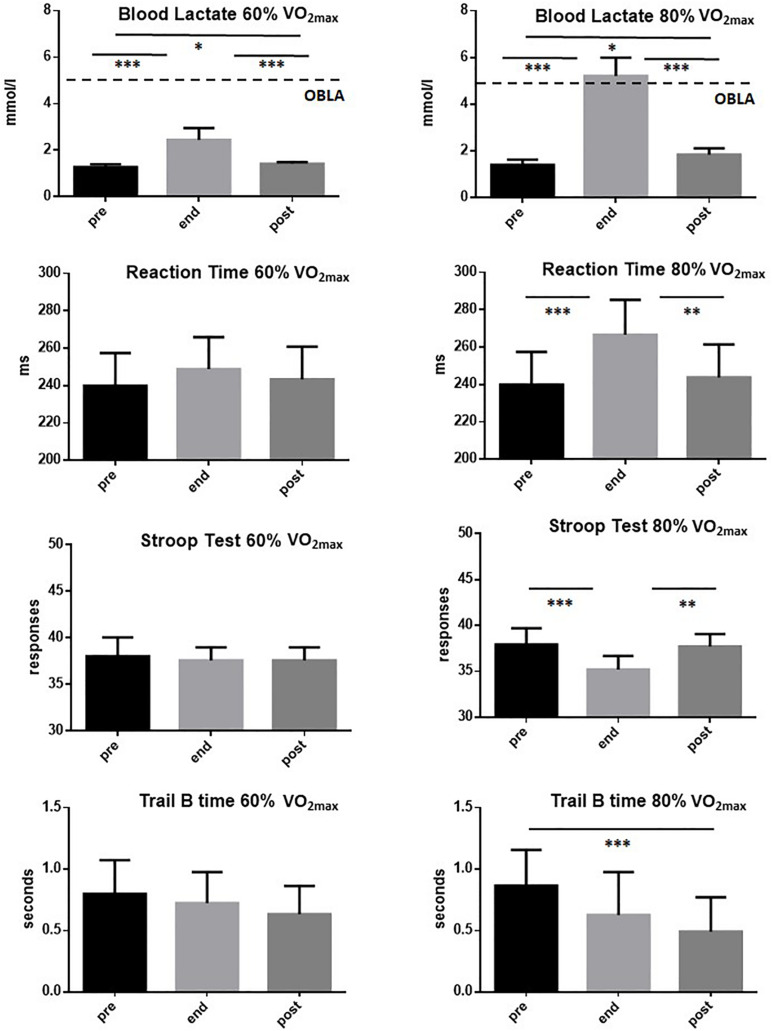
Mean values (±SD) of blood lactate, reaction time, Stroop test, and time for execution of Trial Making Test B of the 20 participants performing a voluntary 30-min exercise at 60 and 80% VO2max. Measurements were taken 10 min before (pre) the beginning of exercise (gray area), at its end and 10 min after the conclusion (post). The dotted line indicates the level (4 mmol/l) of OBLA. Symbols from ANOVA with Tukey’s multiple comparison test: ∗p < 0.05, ∗∗p < 0.01, ∗∗∗p < 0.001.